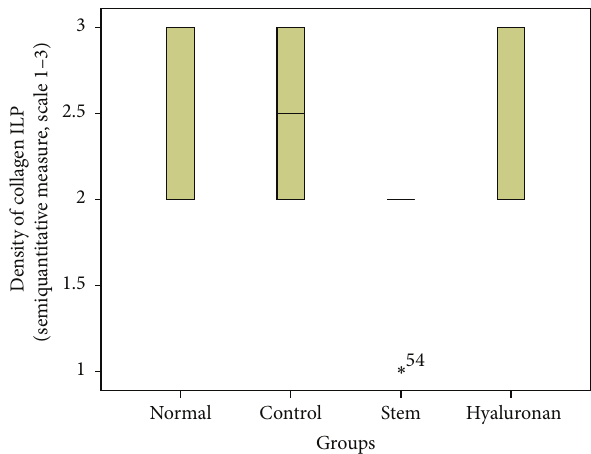
Figure 17: Density of elastin in the superficial lamina propria (SLP). Normal = normal/control group, control = scarred/control group, stem = stem cell group, and hyaluronan = hyaluronan group.